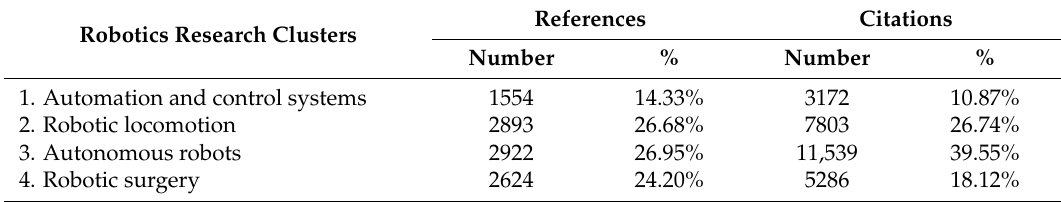
Table 6. References and citations from social robotics to clusters in the robotics network. Robotics Research